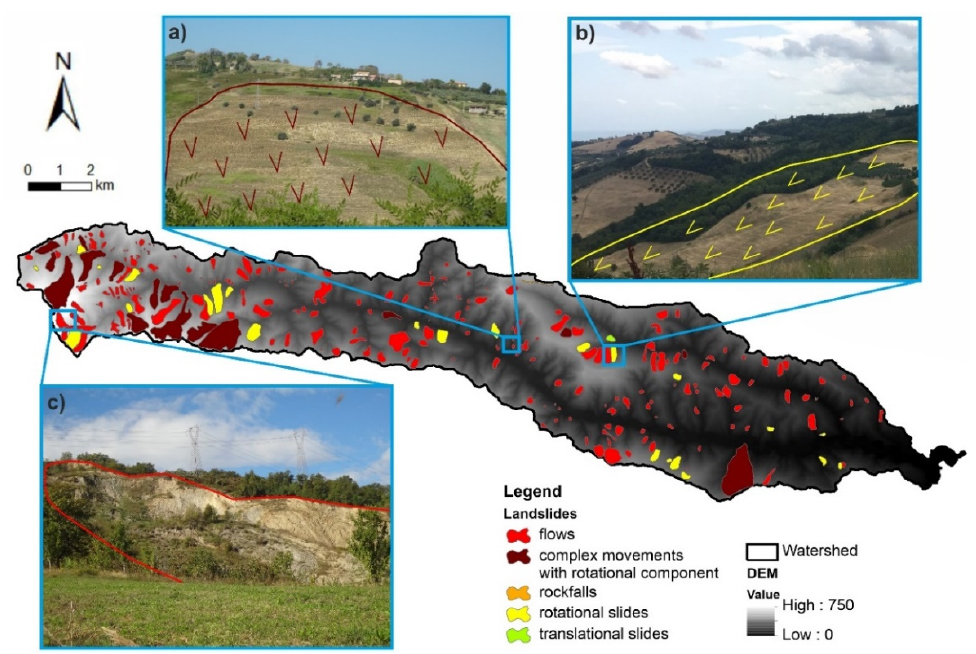
Figure 7. Landslide inventory map with some details of the most representative landslides: ( a ) complex landslide with rotational component (#162); ( b ) rotational landslide (#251); ( c ) flow-type landslide (#26).